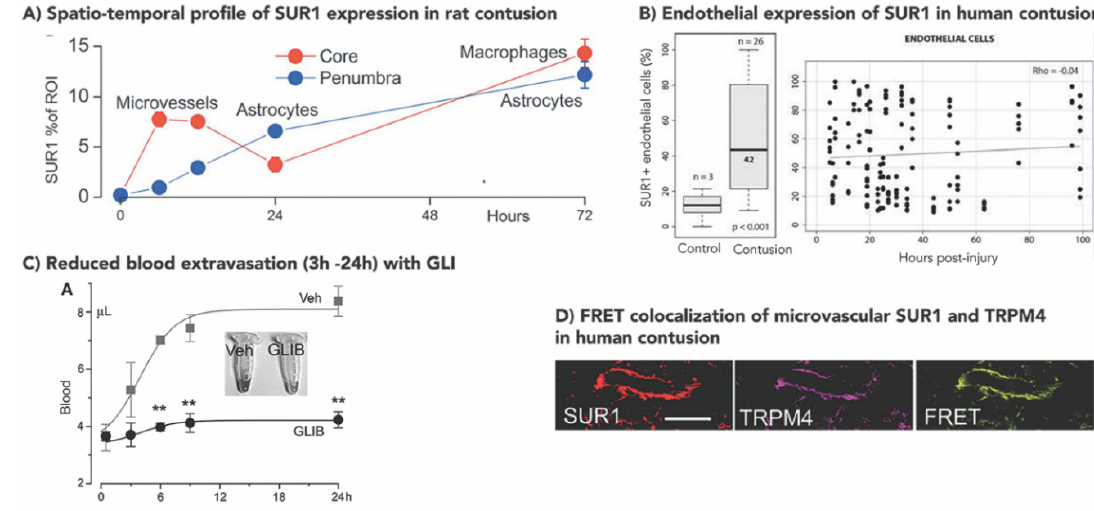
Figure 3. SUR1 expression and inhibition in contusion TBI. ( A ) Spatio-temporal profile of SUR1 expression in rat contusion. Graph of quantified SUR1 expression in core contusion (red) demonstrating prominent early expression in microvessels that decreases by 24 h, and increased expression in macrophages by 72 h. SUR1 expression in penumbra (blue) is predominantly astrocytic at all time points, with highest levels observed at 72 h. Adapted with permission from Gerzanich et al., 2019. ( B ) Endothelial expression of SUR1 in human contusion. The left panel shows a box-plot demonstrating a significantly higher proportion of SUR1 + endothelial cells in contusion vs. control samples ( p < 0.001). The panel on the right demonstrates no correlation between % of SUR1 + endothelial cells and time since injury. Adapted with permission from Martinez-Valverde et al., 2015. ( C ) Reduced blood extravasation (3 h–24 h) with glibenclamide (GLI). Graph demonstrating mean quantified volume of extravasated blood at 0, 3, 6, 12, and 24 h (n = 3/group at all time points except 5/group at 24 h) in vehicle (grey squares) vs. GLI treated (black circles) rats after focal cortical impact. There is minimal increase in extravasated blood in the GLI treated group at 24 h vs. baseline. However, extravasated blood volume almost doubles by 24 h in vehicle rats. Differences between extravasated blood volumes in GLI treated vs. vehicle rats appear by 3 h, become significant by 6 h, and persist at 24 h. Error bars = standard error. ** = p < 0.01. Adapted with permission from Simard et al., 2009. ( D ) ImmunoFRET images from human contusion tissue for SUR1 (red) and TRPM4 (purple) demonstrating co-assembly of these heteromers (yellow) in a microvessel. Scale bar= 100 μ m. Adapted with permission from Gerzanich et al., 2019. 3.2. Increased Human SUR1±TRPM4 Expression in TBI In a cohort of 26 patients with contusion, neuronal SUR1 expression was almost threefold greater in contusions vs. controls (meningioma, schwanomma, rhabdoid tumor, p < 0.001) [62]. While detected as early as 6 h post injury, neuronal SUR1 expression peaked at 24 h after which it stabilized. Early SUR1 expression was also detected in CD31 + endothelial cells (again, approximately threefold greater expression vs. controls). However, no temporal trend was noted in these cells; microvascular SUR1 expression remained elevated up to 100 h post-injury (Figure 3B). Semiquantitative immunohistochemistry did not detect any SUR1 expression in control GFAP+ glial cells (astrocytes), activated microglia/macrophages or neutrophils, whereas moderate SUR1 expression was found in all these cells-types after contusion. Most circulating neutrophils were SUR1 negative; however, those from brain parenchyma were SUR1 positive. The same group also identified KIR6.2 overexpression in contusional GFAP+ glial cells (astrocytes), consistent with findings in rodents. TRPM4 expression was not assessed in this study [51]. Deconstructing regional expression of SUR1, TRPM4, and KIR6.2 in contusion core vs. penumbra, analogous to the rodent experiments described above, yielded similar results [50]. Although temporal trends were not evaluated in human tissue, core lesions demonstrated SUR1 and